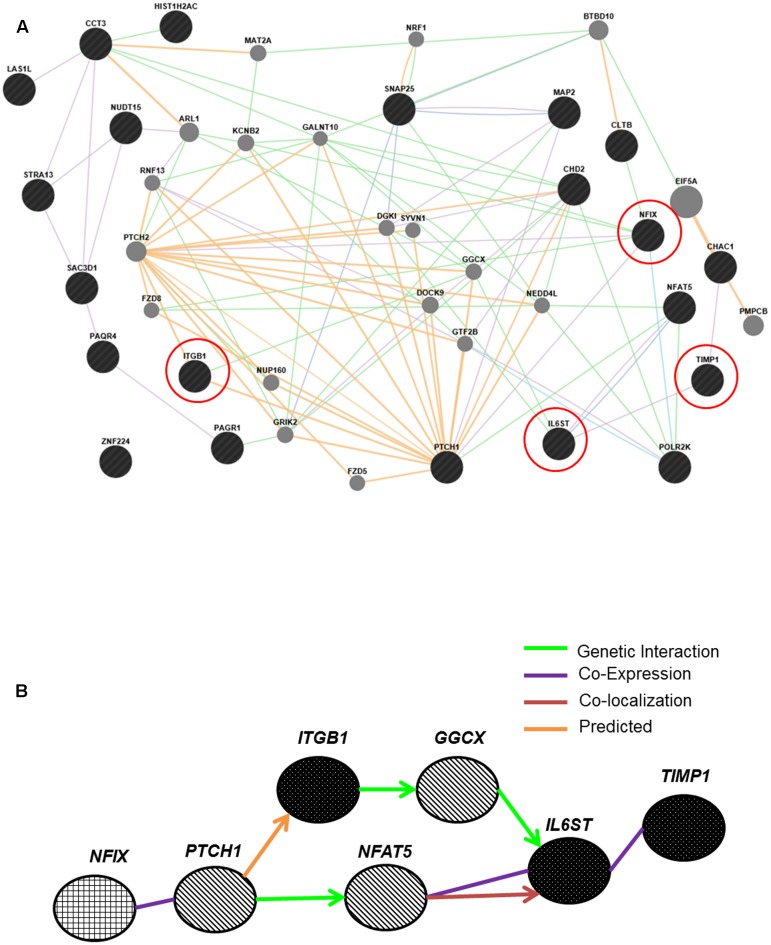
Pathways created by GeneMANIA connect the master regulator NFIX and its regulated genes IL6ST, TIMP1 and ITGB1.
(A) 17 differentially expressed genes from microarray analyses showed connection with all regulated genes and NFIX. Some genes showed co-expression with NFIX, including PTCH1. (B) Successful construction of a new transcriptional network from both meta-analysis and microarray analyses. NFIX was identified as a master regulator that regulates the ITGB1, TIMP1 and IL6ST genes. Three new entities: the PTCH1, NFAT5 and GGCX, were also included in this metastasis regulatory network for lung cancer. NFIX is the master regulator; IL6ST, TIMP1 and ITGB1 are the NFIX-regulated genes and PTCH1, NFAT5 and GGCX are genes involved in the NFIX transcriptional regulatory network.